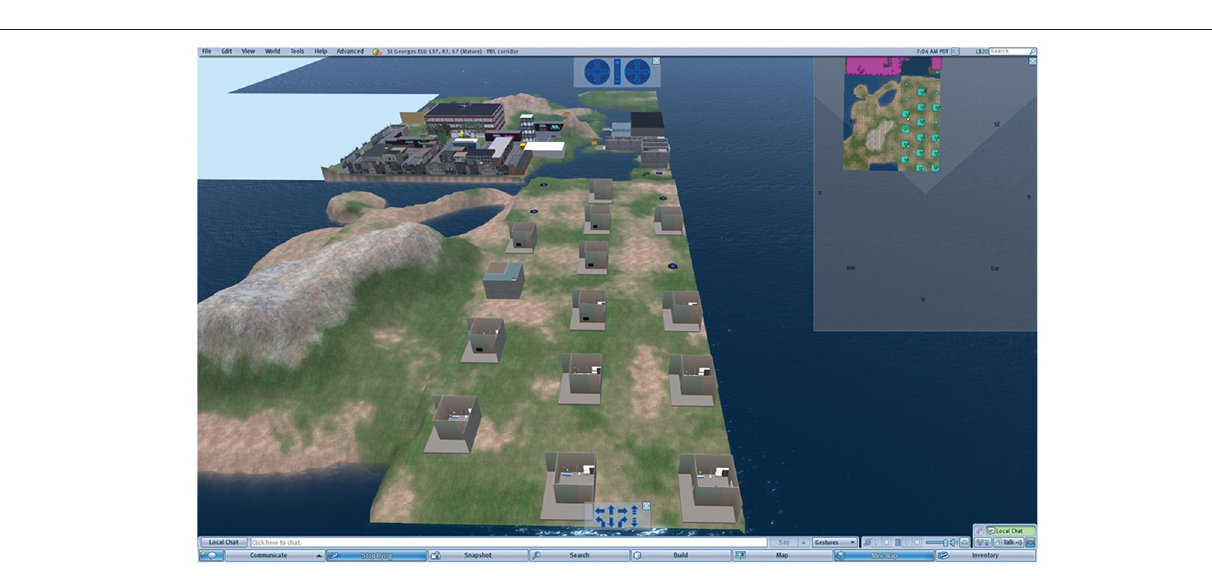
FIGURE 5 | Image from within Second Life showing the virtual base-rooms on the St George’s Island with surrounding buildings and landscape. In the foreground on the right, the 18 virtual baserooms are shown by either (i) blue circles, which means the PBL group has not yet activated its virtual GP surgery, (ii) the rectangular boxes of the PBL surgery. Most groups have reached the first phase, the GP surgery, but the group 4 up on the left-hand row, has reached the renal clinic which has a different external size. A by-product of SL/PBL was that differential progress of the PBL groups could be